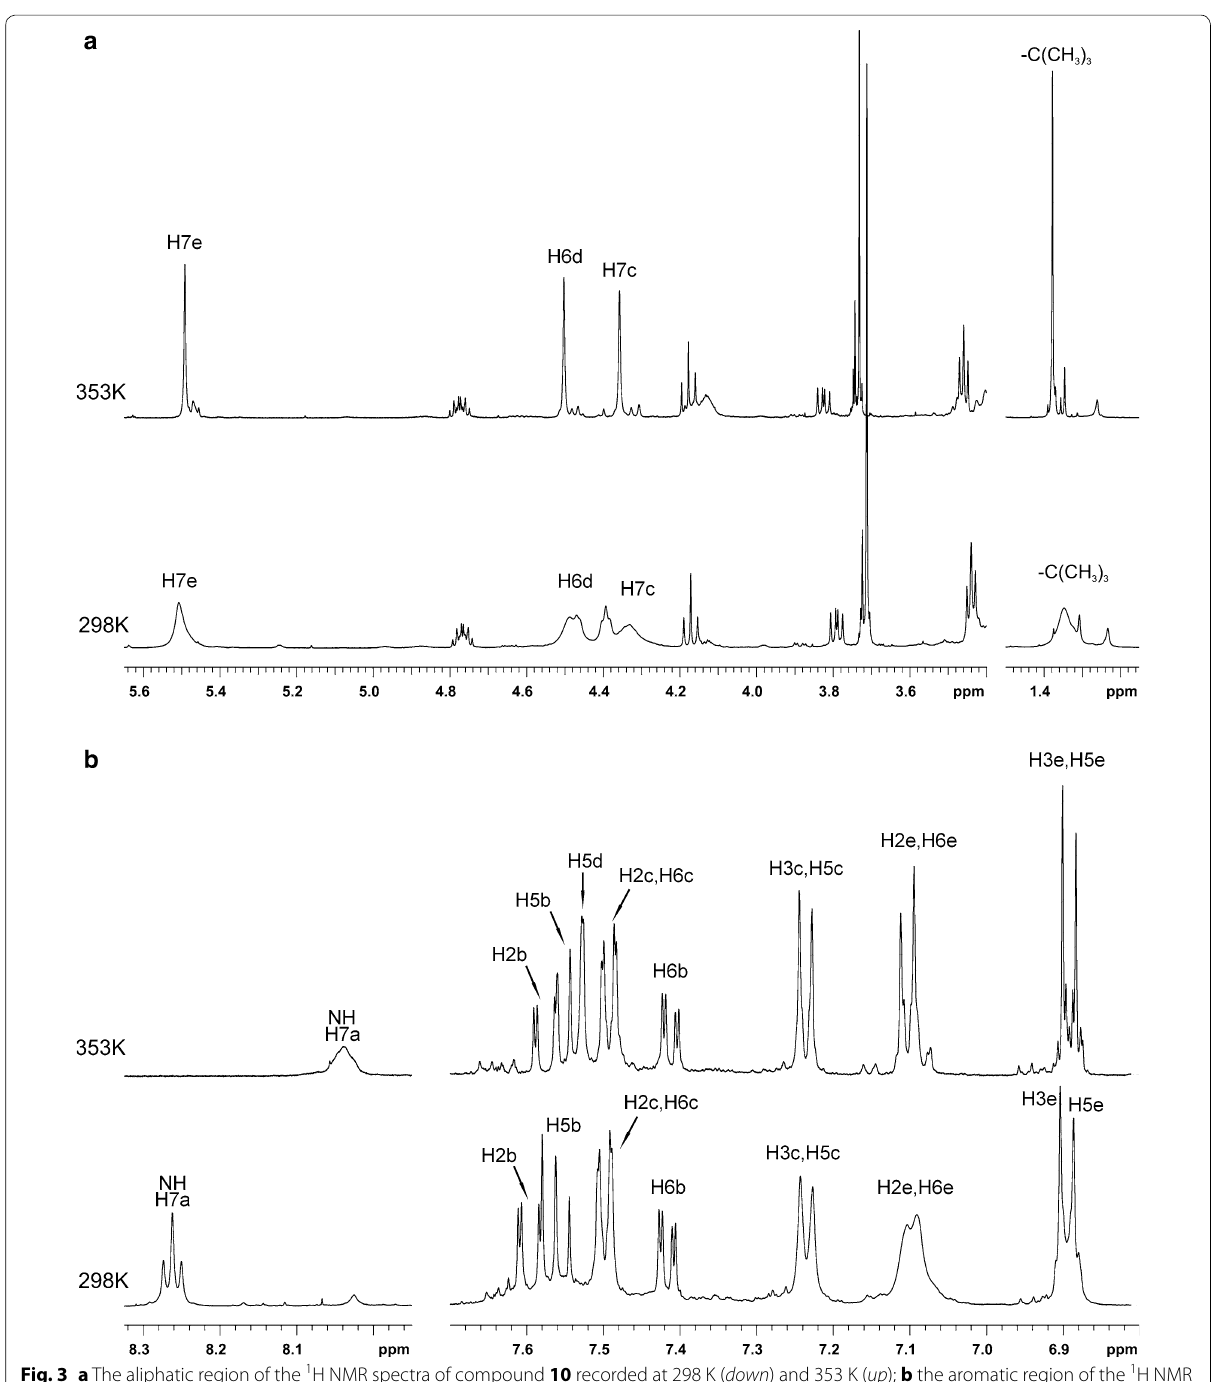
Fig. 3 a The aliphatic region of the 1 H NMR spectra of compound 10 recorded at 298 K ( down ) and 353 K ( up ); b the aromatic region of the 1 H NMR spectra of compound 10 recorded at 298 K ( down ) and 353 K ( up